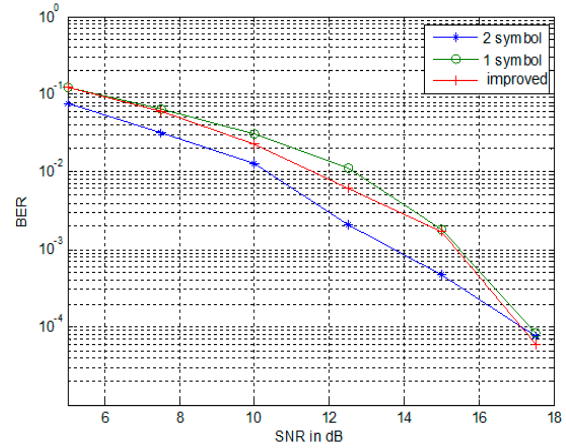
Figure 5. Performance comparison of pilot pattern with one symbol and two symbols.